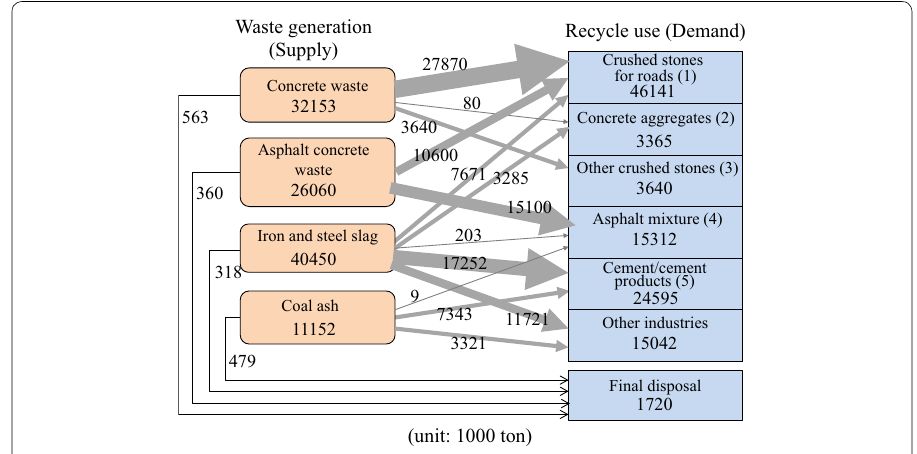
Fig. 3 Material flows of non-metallic mineral wastes in